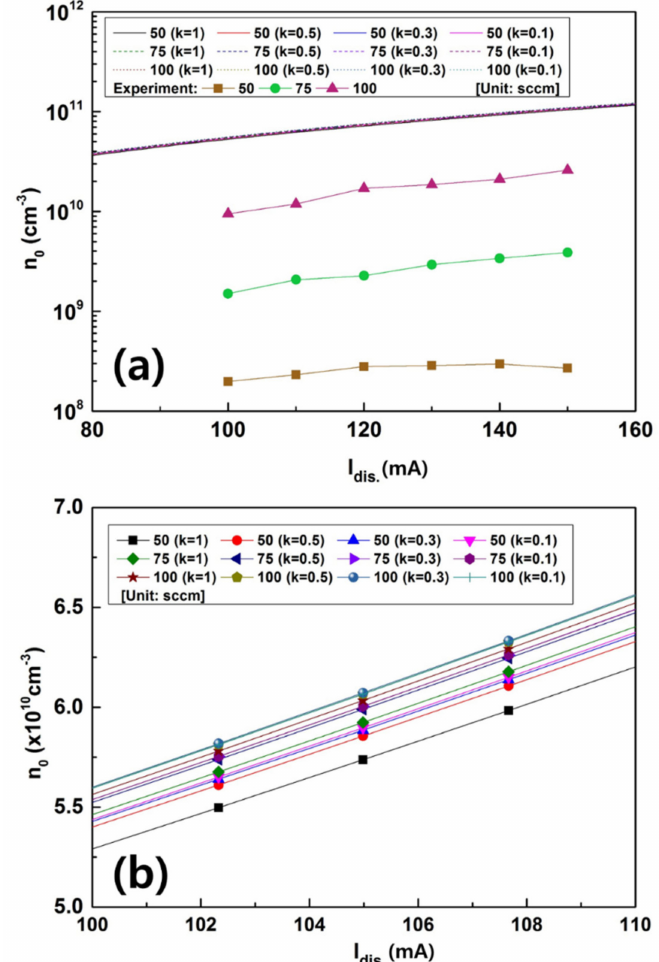
Figure 7. ( a ) The n 0 profiles as a function of discharge currents with various gas flow rates for comparing numerical calculations (z: 0 cm, at a center of plasma source and k : 0.1–1) and experimental results (z: 3 cm, at plasma jet from a nozzle exit) and ( b ) numerical calculation results in